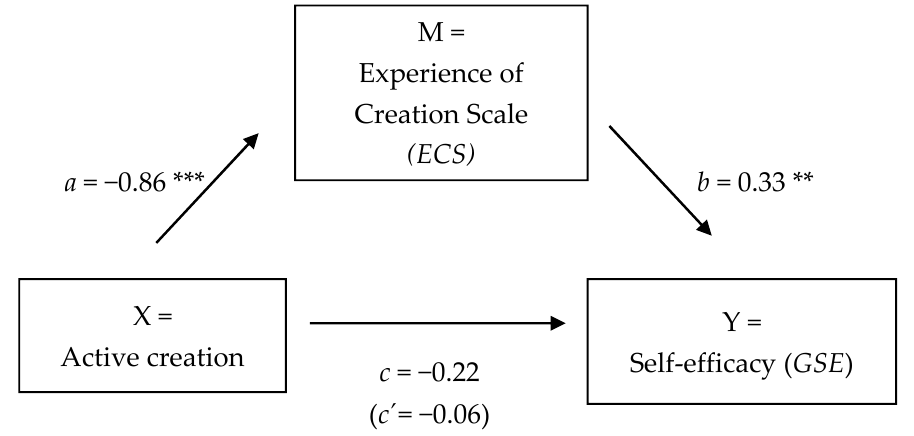
Figure 6 . The effect of active creation on self-efficacy ( GSE ), mediated by the Experience of Creation Scale ( ECS ; full mediation) . Note: * p < 0.05, ** p < 0.01, *** p < 0.001, GSE = General Self-Efficacy Scale [24].